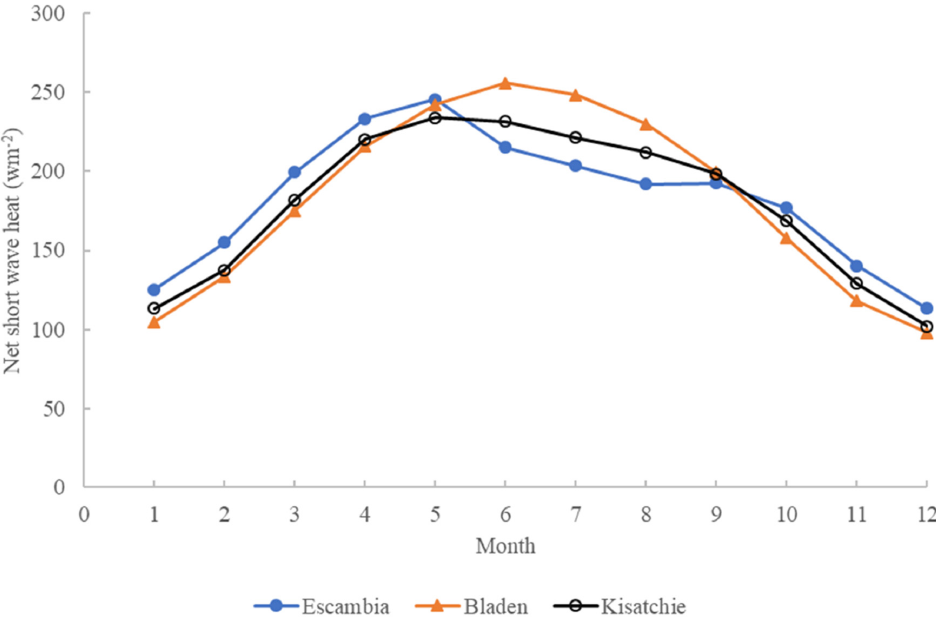
Figure 13. Dynamics of the integrated monthly net shortwave in the three areas.